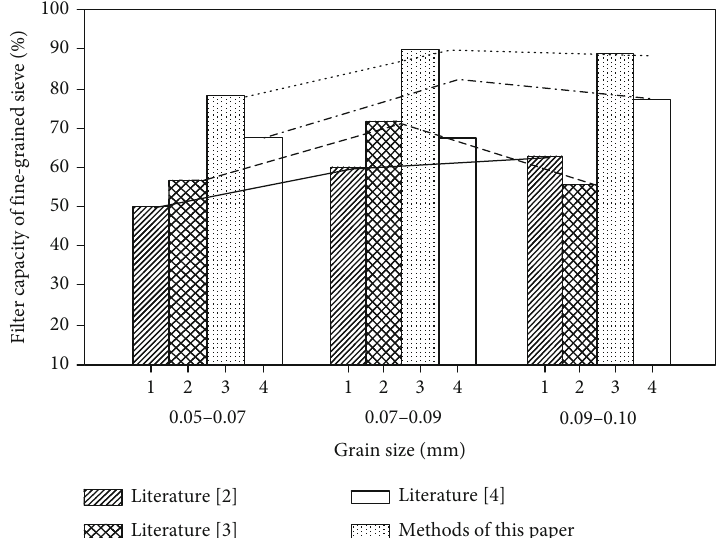
Figure 3: Testing result of fi ne-grained sieve fi lter